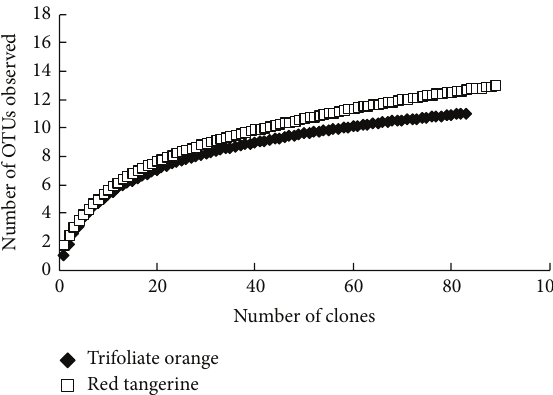
Figure3:RarefactioncurvesusingAMfungalSSUrDNAsequences from roots of trifoliate orange and red tangerine in